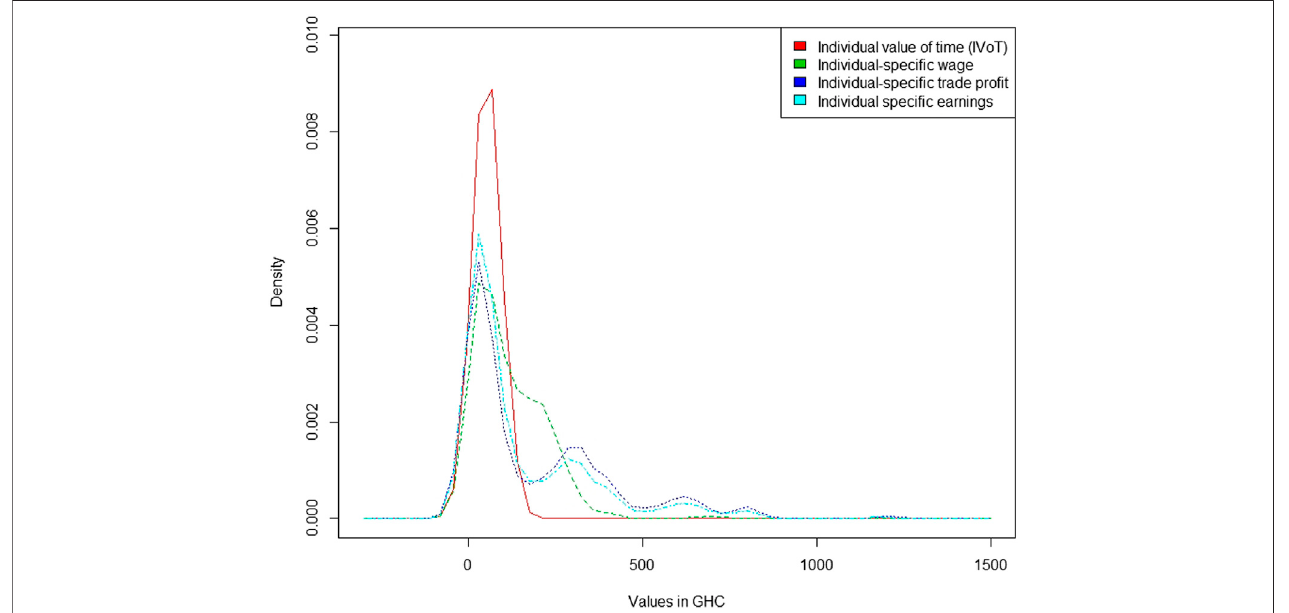
FIGURE 5 | Kernel density plot of Time IVoT and individual-speci fi c wage, trade pro fi t and earning values in the urban study site.